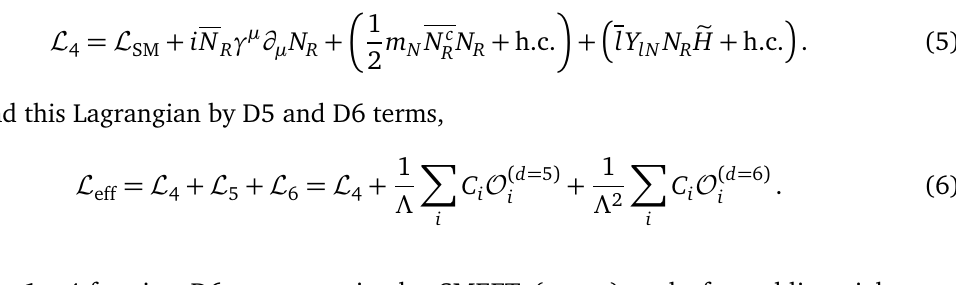
Table 1: 4-fermion D6 operators in the SMEFT (upper) and after adding right- handed neutrino singlets (lower) to generate the ν SMEFT. Note that l α and q α